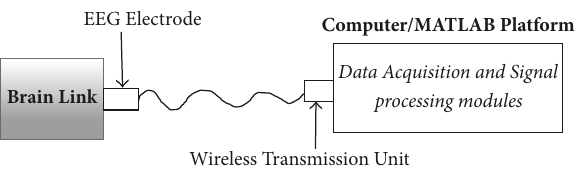
Figure 1: Schematic view of EEG fatigue monitoring